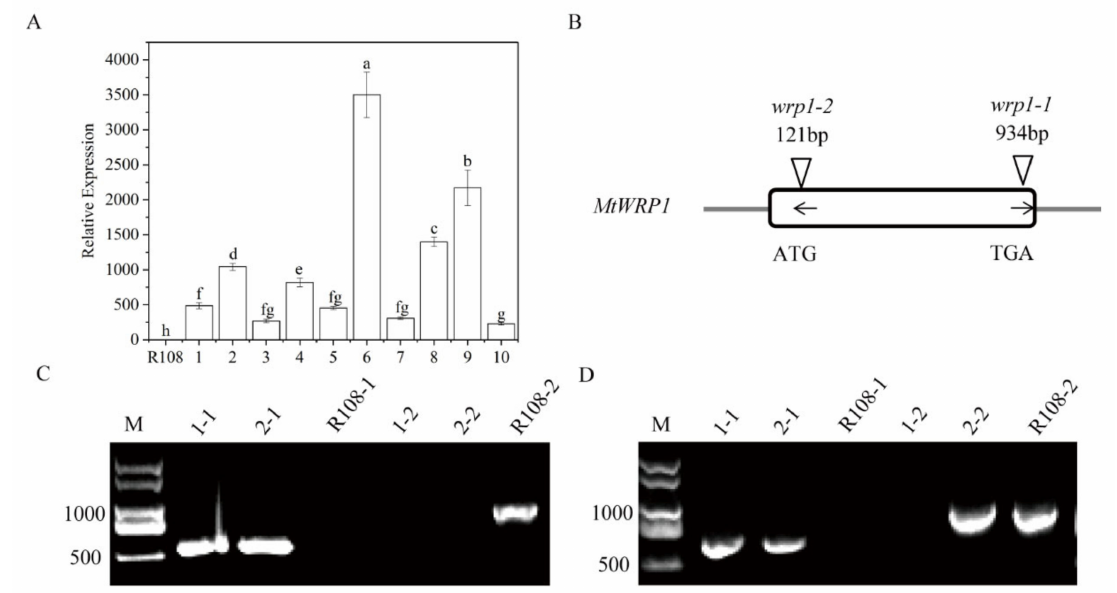
Figure 6. Identification of overexpression transgenic lines and MtWRP1 mutants in M. truncatula: ( A ) The transcript levels of MtWRP1 in transgenic M. truncatula . 1–10: transgenic lines. Data represent mean ± SD ( n = three independent biological replicates). ( B ) Schematic representation of MtWRP1 gene model and the Tnt1 insertion sites. The box indicated the coding region of MtWRP1, which contained only one exon. The position of Tnt1 insertions was indicated in base pairs (bp) with arrowheads. The orientation of Tnt1 insertions was indicated by black arrows. ( C ) RT-PCR analysis of MtWRP1 expression in wrp1-1 . Lane 1-1, 2-1, and R108-1 were PCR-based identification of Tnt1 insertion (544 bp) using primers MtWRP1-R and Tnt1-F2. Lane 1-2, 2-2 and R108-2 were PCR-based identification of MtWRP1 (984 bp) using primers MtWRP1-F and MtWRP1-R. R108 was used as the wild type control. M was a DL2000 DNA marker. ( D ) RT-PCR analysis of MtWRP1 expression in wrp1-2 . Lane 1-1, 2-1, and R108-1 were PCR-based identification of Tnt1 insertion (677 bp) using primers MtWRP1-F and Tnt1-F2. Lane 1-2, 2-2, and R108-2 were PCR-based identification of MtWRP1 (984 bp) using primers MtWRP1-F and MtWRP1-R. R108 was control. M was a DL2000 DNA marker. Data represent mean ± SD ( n = three independent biological replicates). Different letters above the standard error bars indicated a significant difference between the lines as determined by Duncan’s multiple range test ( p <